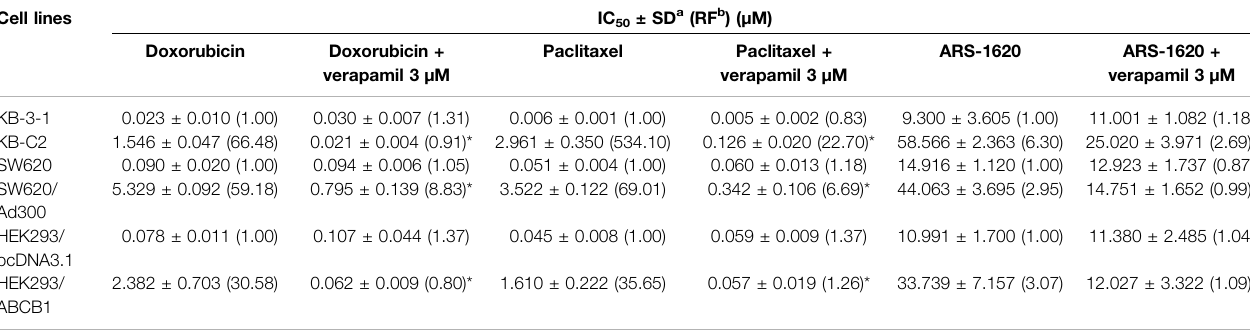
TABLE 1 | The cytotoxicity of ARS-1620 on ABCB1-overexpressing cancer cells. Cell